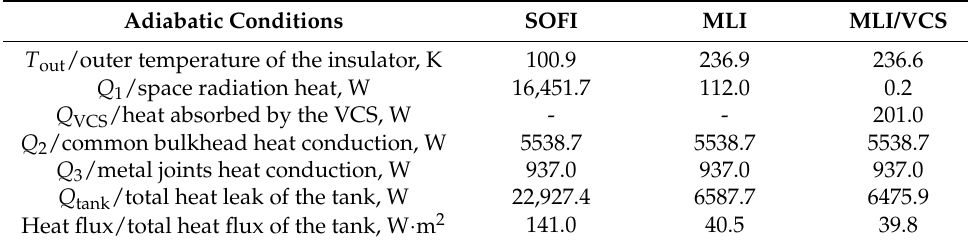
Table 1. Comparison of heat leak under different adiabatic conditions.